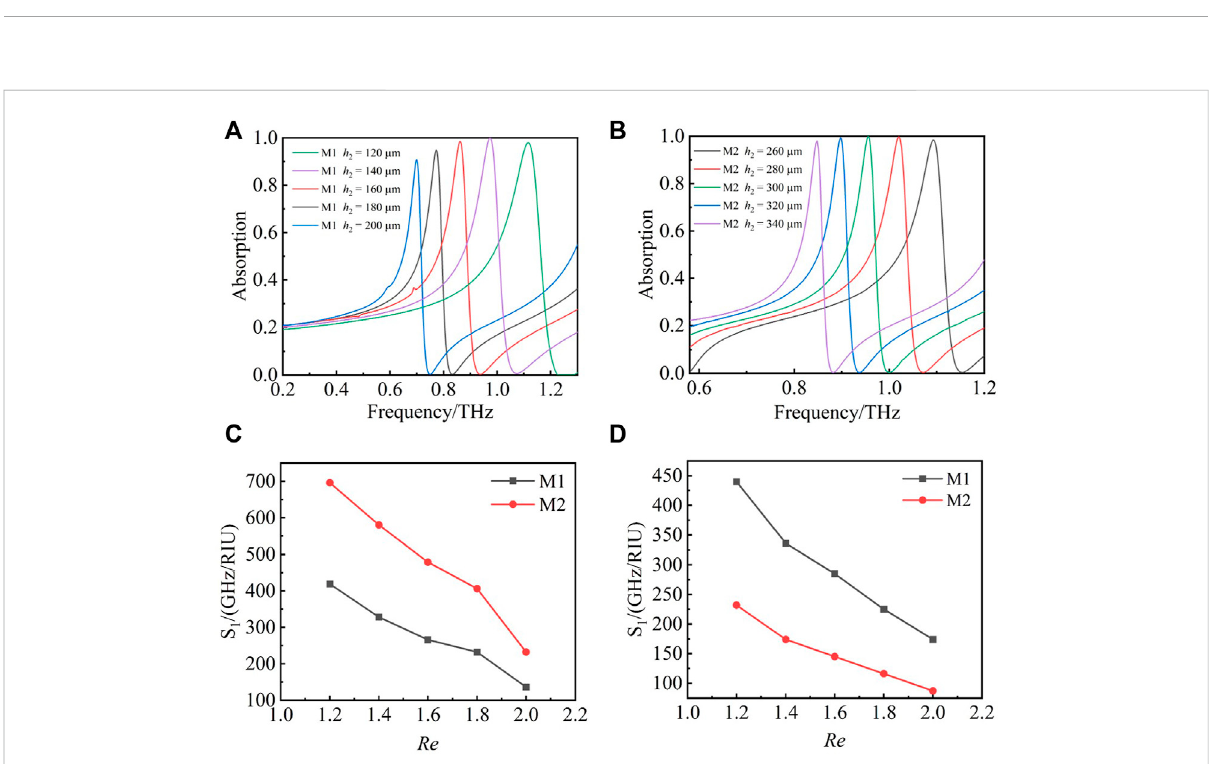
FIGURE 10 (A) Absorption line of the resonance peak M1 as h 2 varies from 120 to 200 μ m. (B) Absorption line of the resonance peak M2 as h 2 varies from 260 to 340 μ m. (C) Line graph of S 1 of the absorption corresponding to Re from 1 to 2 when h 2 (cid:1) 140 μ m. (D) Line graph of S 1 of the absorption corresponding to Re from 1 to 2 when h 2 (cid:1) 280 μ